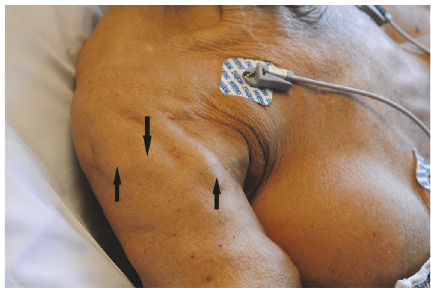
Figure 1: Palpable nodules (arrows) over the right arm.